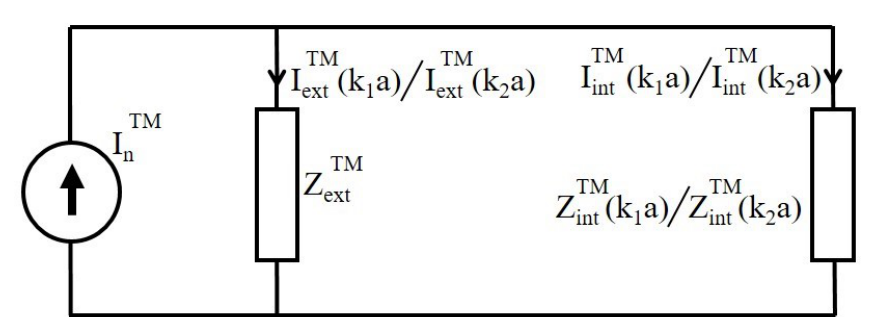
( k ) / I TM ( k ) ) and external ( I TM 2 a 1 a int int